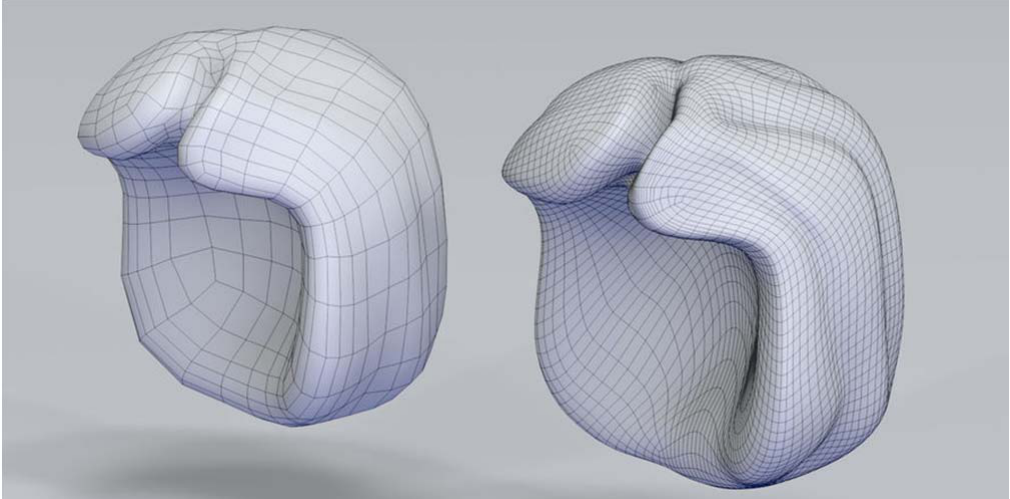
Figure 11. Mesh with less elements (left) and mesh with more elements (right) [6]